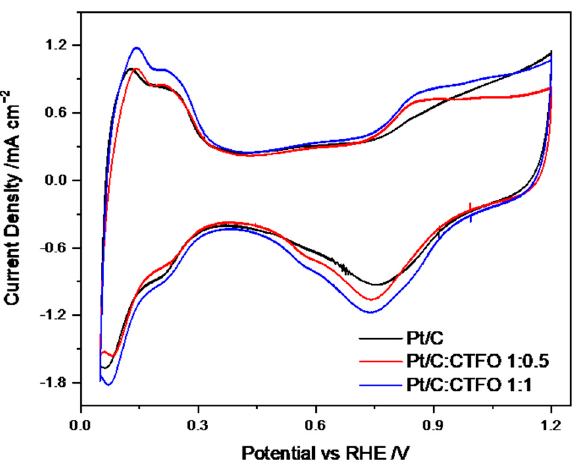
Figure 6. CV profiles of all the catalyst samples recorded under nitrogen flux at 20 mV s − 1 .